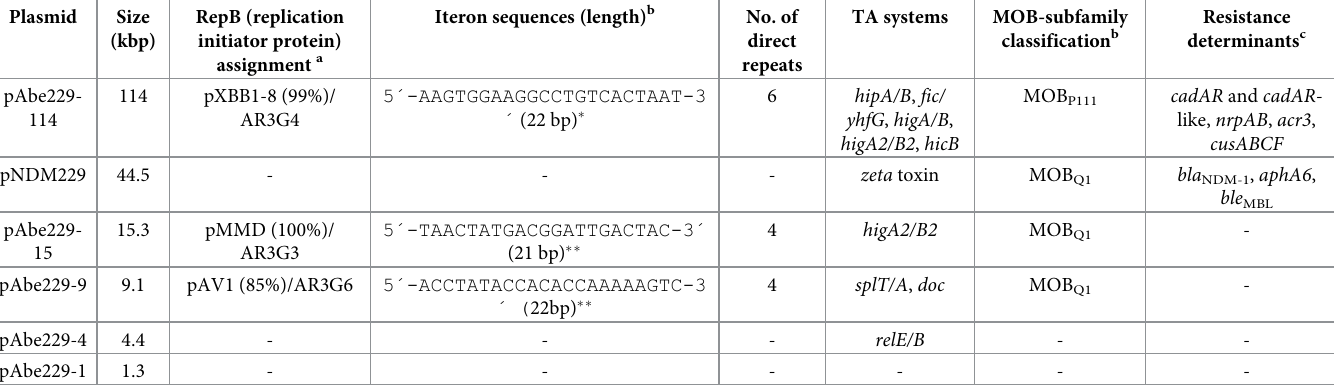
Table 1. Characteristics of A . bereziniae HPC229 plasmids.